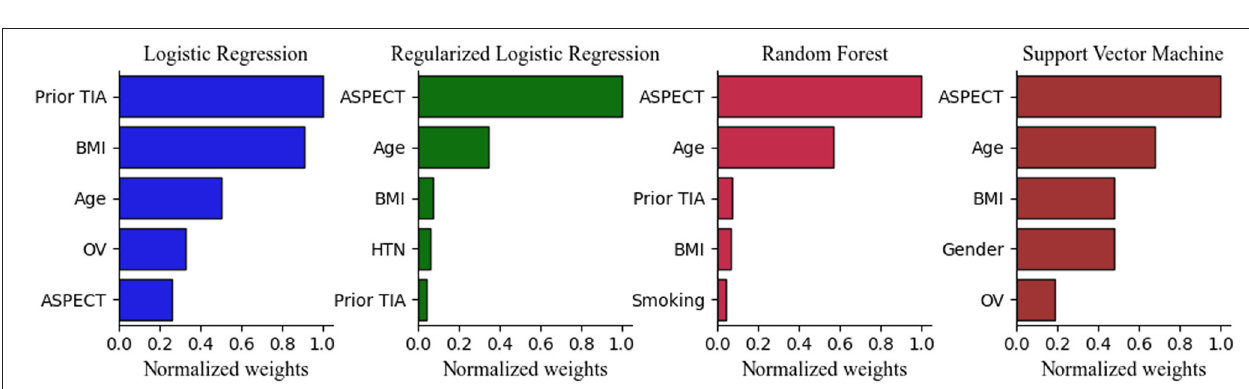
FIGURE 6 | Top 5 Important Features in the Model 2. ASPECT indicates Alberta Stroke Program Early CT Score; BMI, body mass index; HTN, hypertension; LR, logistic regression without regularization; OV, occluded vessels; RF, random forest; RLR, regularized logistic regression; SVM, support vector machine; TIA, transient ischemic